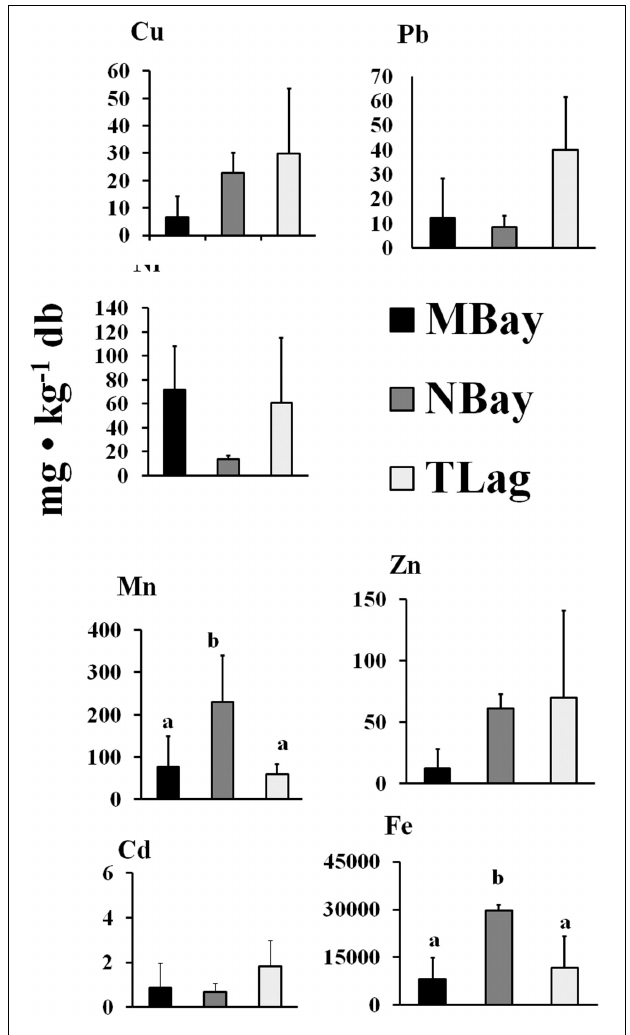
FIGURE 4 | Trace metal concentrations (average ± SD) in surrounding sediments of R. mangle from MBAY, NLAG, and TLAG. Different letters show significant statistical differences ( p ≤ 0.05).